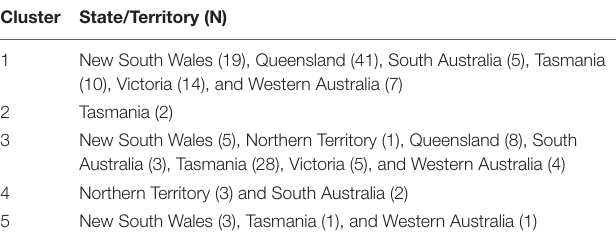
TABLE 5 | Australian state and territory distribution over five clusters along with the number of outfalls sites in each group. Cluster State/Territory